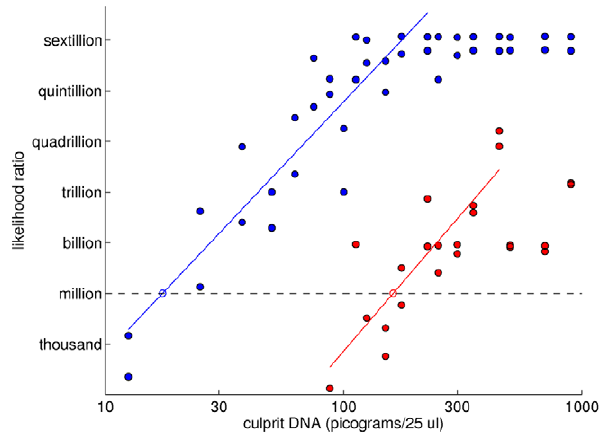
Figure 8. The information gap in detection sensitivity between quantitative and qualitative DNA interpretation methods. Two log-log scatter plots are shown of LR match information (y-axis) versus culprit DNA quantity. There is an order of magnitude information gap between the more sensitive quantitative LR1 interpretation method (blue) and the less informative qualitative CPI method (red).